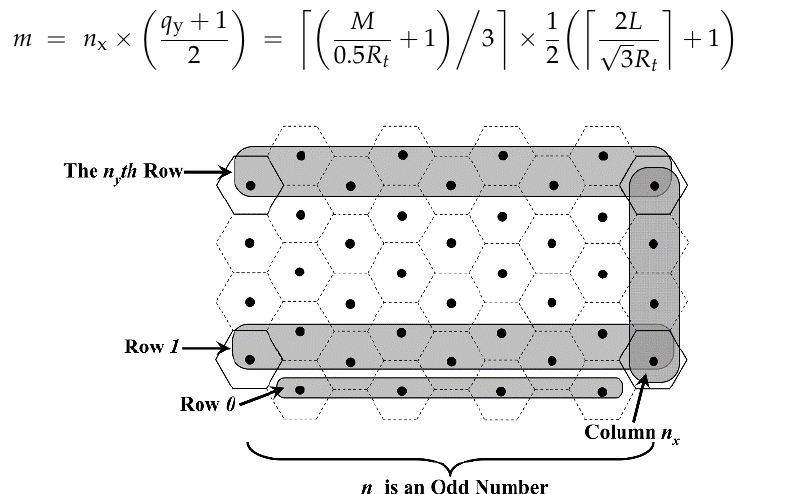
Figure 8. Distribution of VTPs when q y is odd.